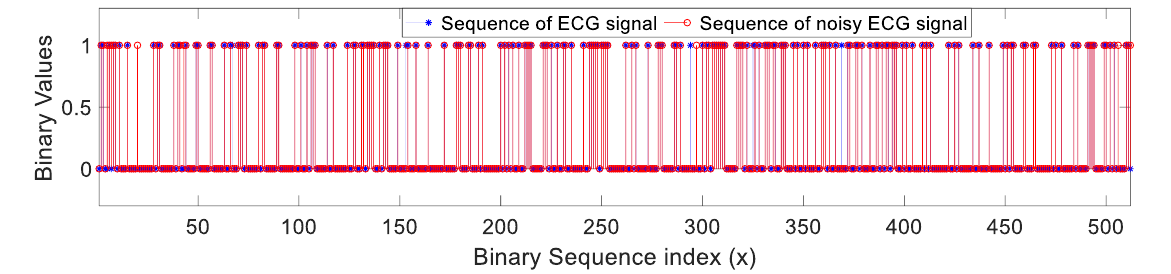
Figure 17. Example of binary sequences of size L = 512 used in the BER calculation for an ECG signal contaminated by “Gaussian” noise with k = 0.06.